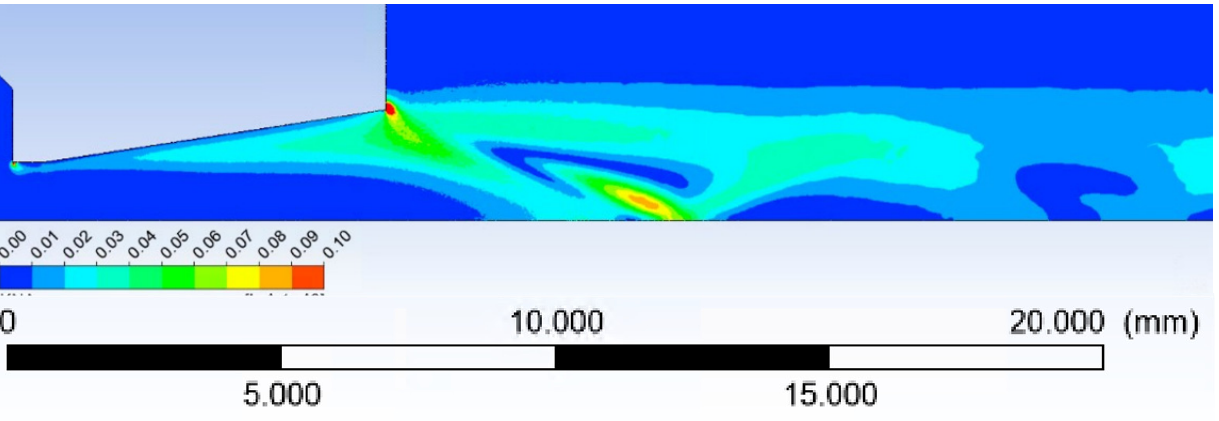
Figure 6. Knudsen number distribution [11].